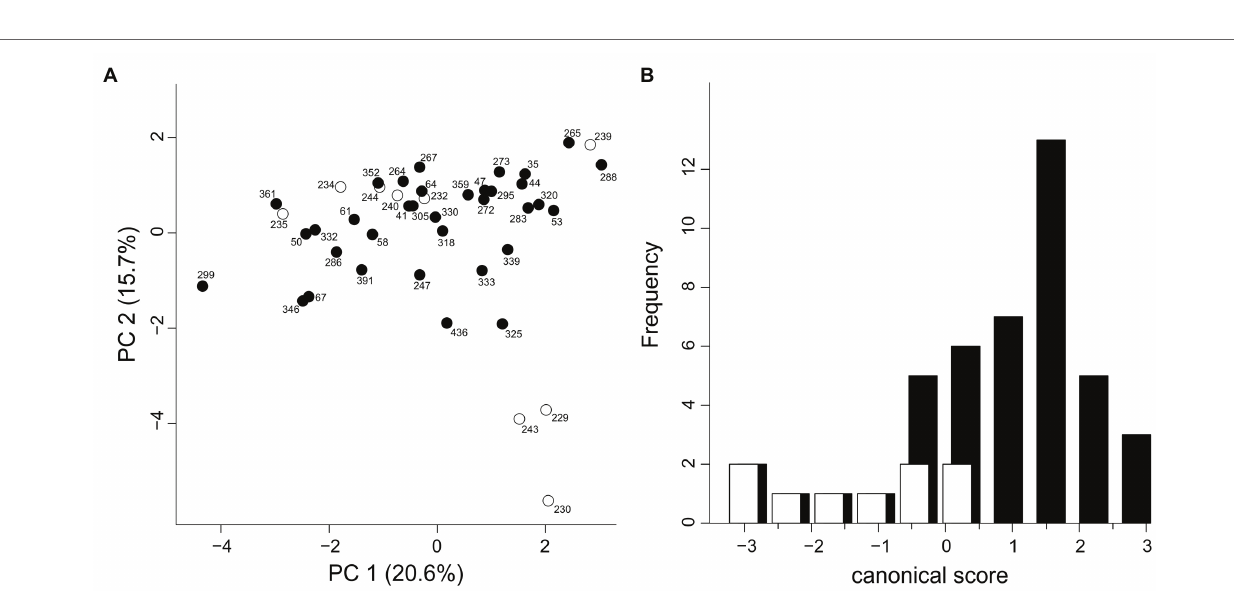
( Table 3 ). Within the Western Group all populations harbor a large number of private alleles indicating many local, weakly interconnected gene pools ( Figure 3 ). In contrast, the South-Eastern Subgroup is heterogeneous; it includes populations with many private alleles both in the north and the south of the subgroup’s distribution in the Alps and the northwestern Balkan Peninsula, respectively, as well as